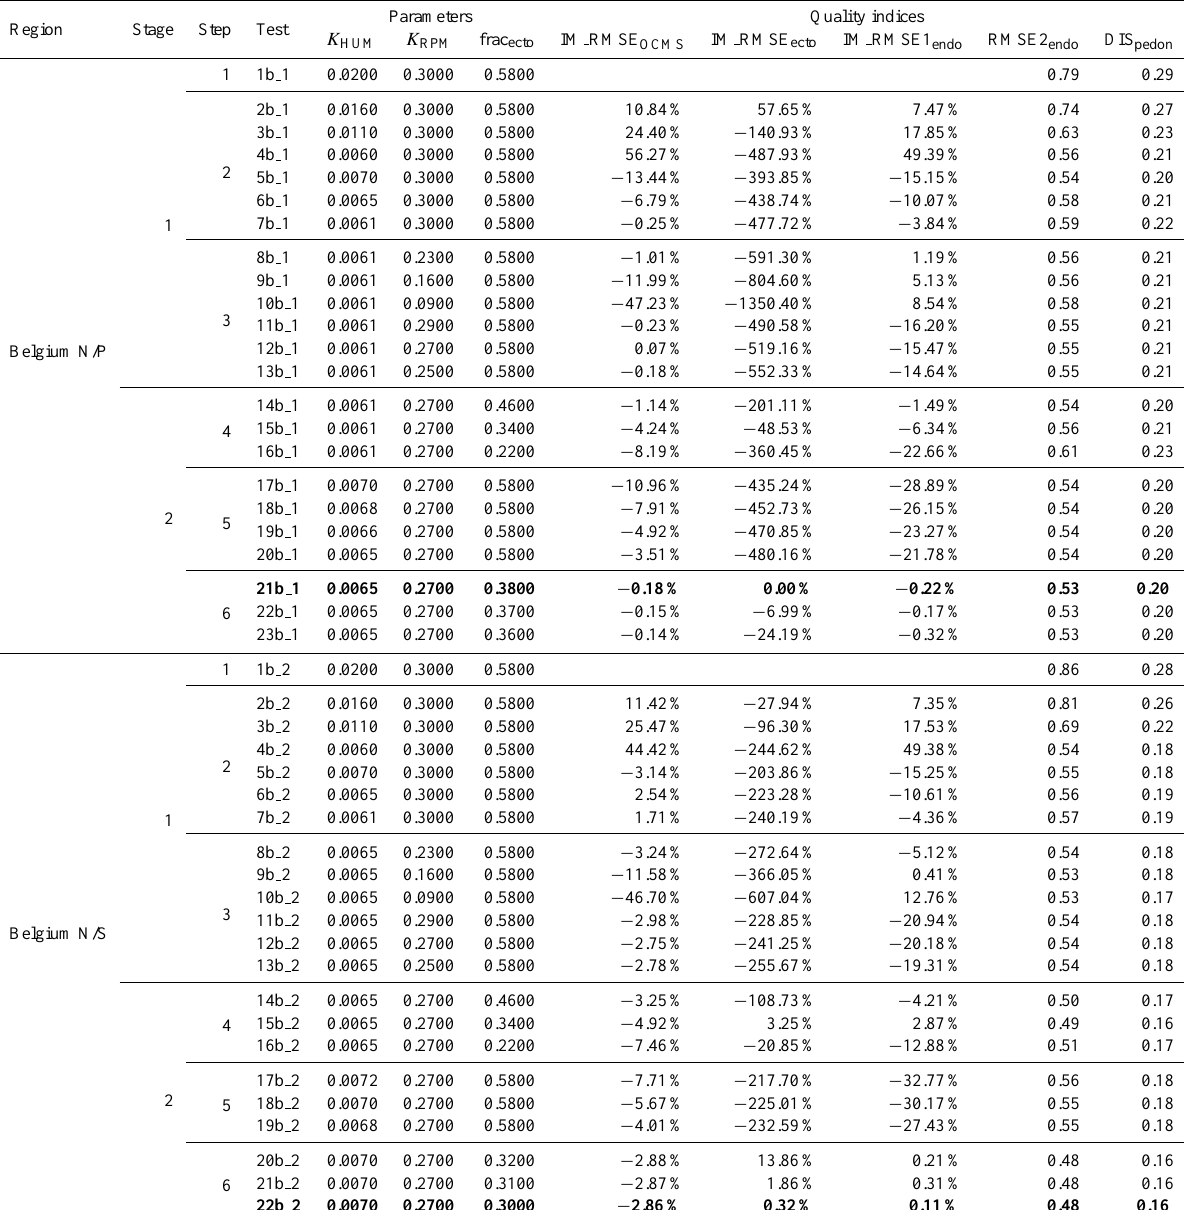
Table 3. Model parameters in the organic C-module in SoilGen2 and quality indices of one group of pedons during the calibration in Belgium and China. Bold numbers indicate the best calibration results for each group of pedons.